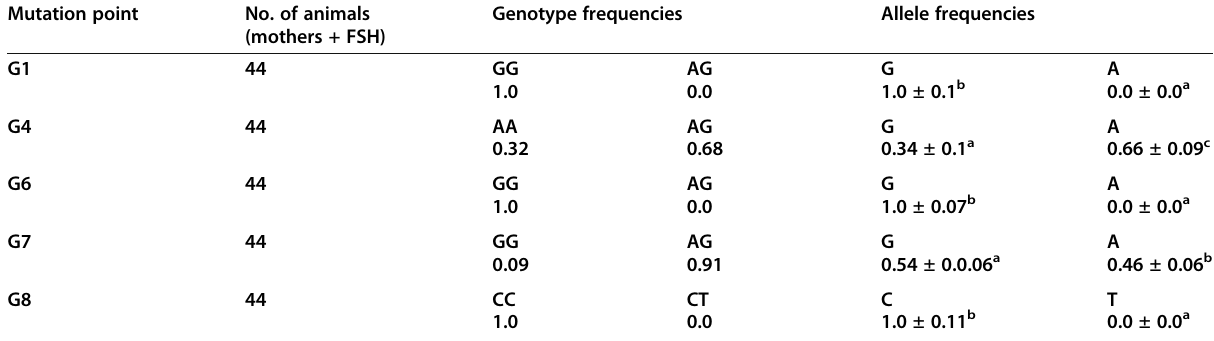
Table 5 Genotype and allele frequencies in mutation points of GDF9 gene of Egyptian goats Mutation